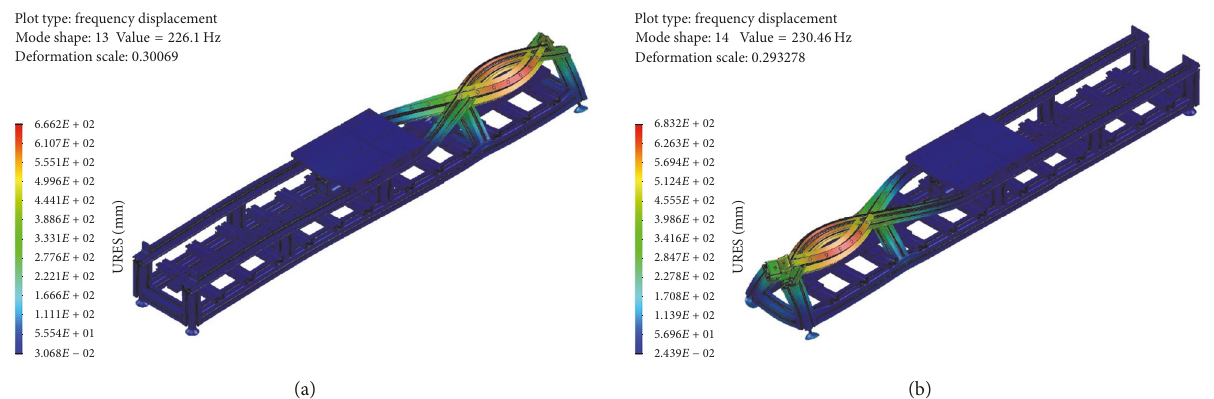
Figure 17: Mode shapes for first-order modes with transversal waves at the top lateral bars for position P3: (a) mode 13 ( 𝑓 ≈ 226 Hz, def. scale ≈ 0.301); (b) mode 14 ( 𝑓 ≈ 230 Hz, def. scale ≈